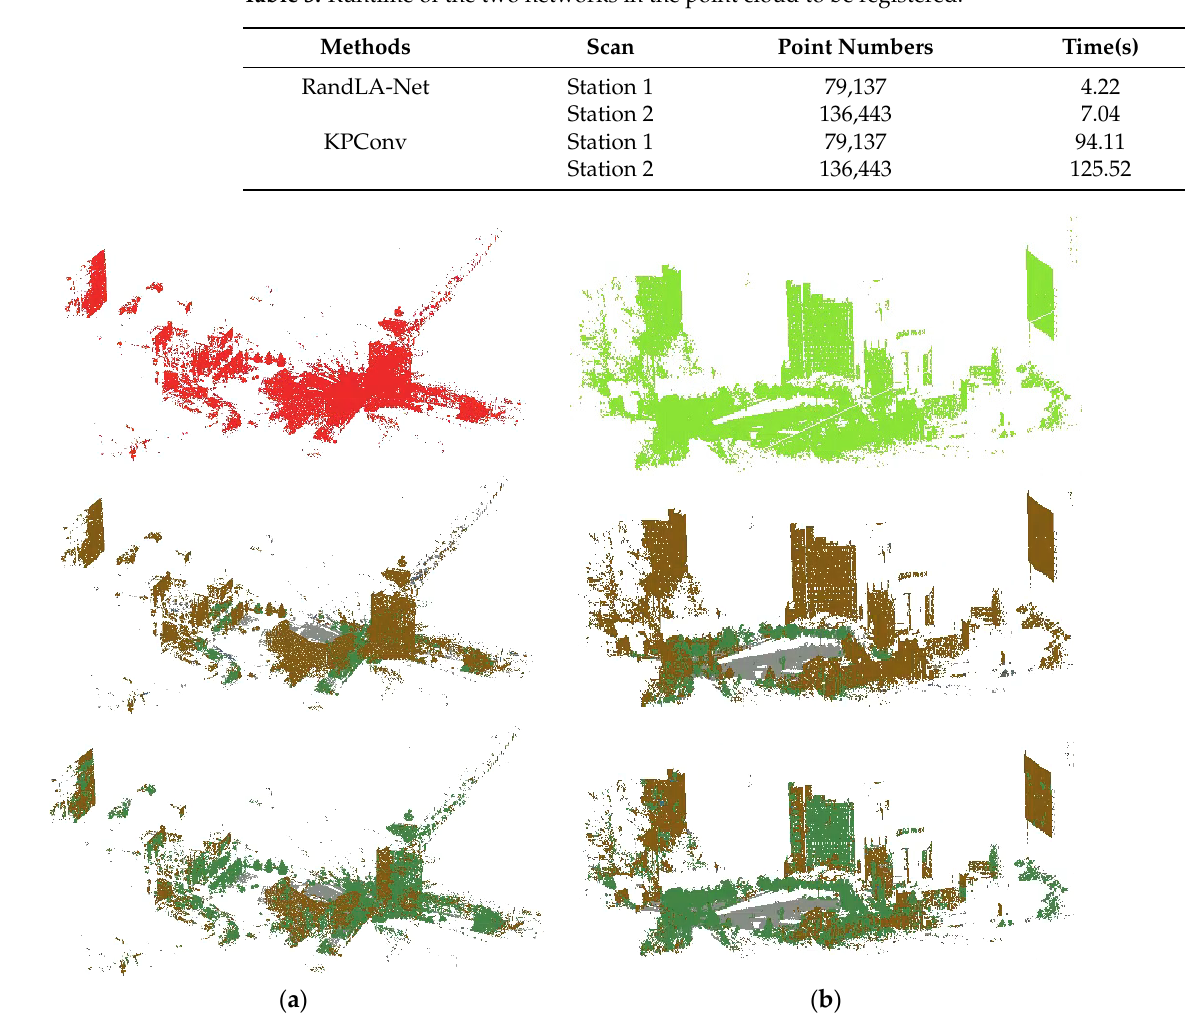
Figure 3. Semantic segmentation visualization of the source and target point clouds. ( a ) Source point cloud and its segmentation result; the former is RandLA-Net, and the latter is KPConv.; ( b ) Target point cloud and its segmentation result. Green represents natural points, gray represents ground points, and brown represents building points.